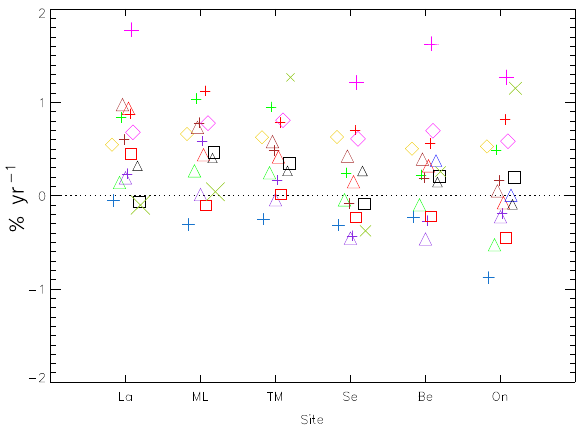
Figure 8. Linear trends at 0.46hPa at each of the six NDACC ground-based sites. Trends are calculated over the data collection period for each instrument shown in Fig. 6. The sites are listed from south to north: Lauder (45 ◦ S), Mauna Loa (20 ◦ N), Table Mountain (34 ◦ N), Seoul (37 ◦ N), Bern (47 ◦ N), and Onsala (57 ◦ N). Symbols are slightly offset from each other along the x axis for legibility. Larger symbols indicate longer